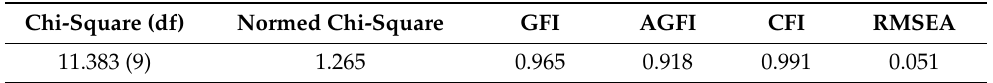
Table 4. Task Performance Model Fit.